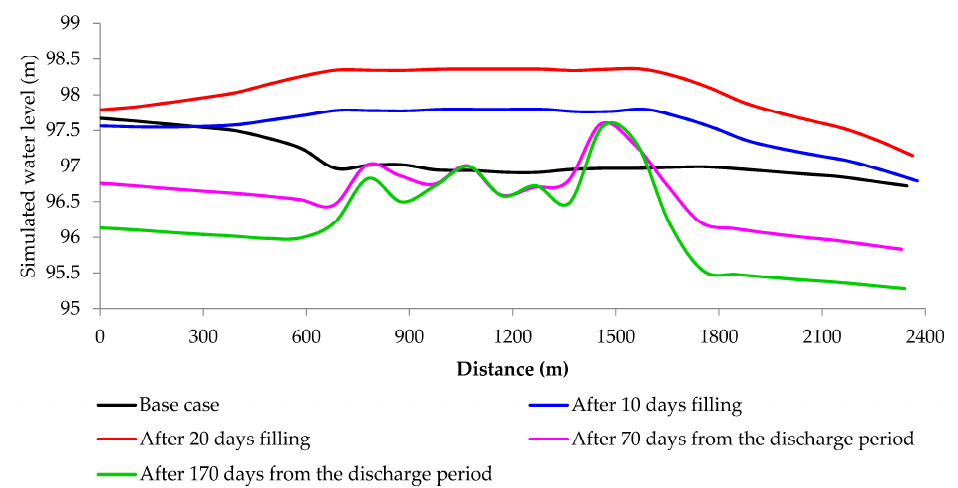
Figure 11. Simulated groundwater levels at a line crossing Lake Okor at 10 and 20 days of the filling period and at 70 and 170 days of the discharge period with respect to the base case.